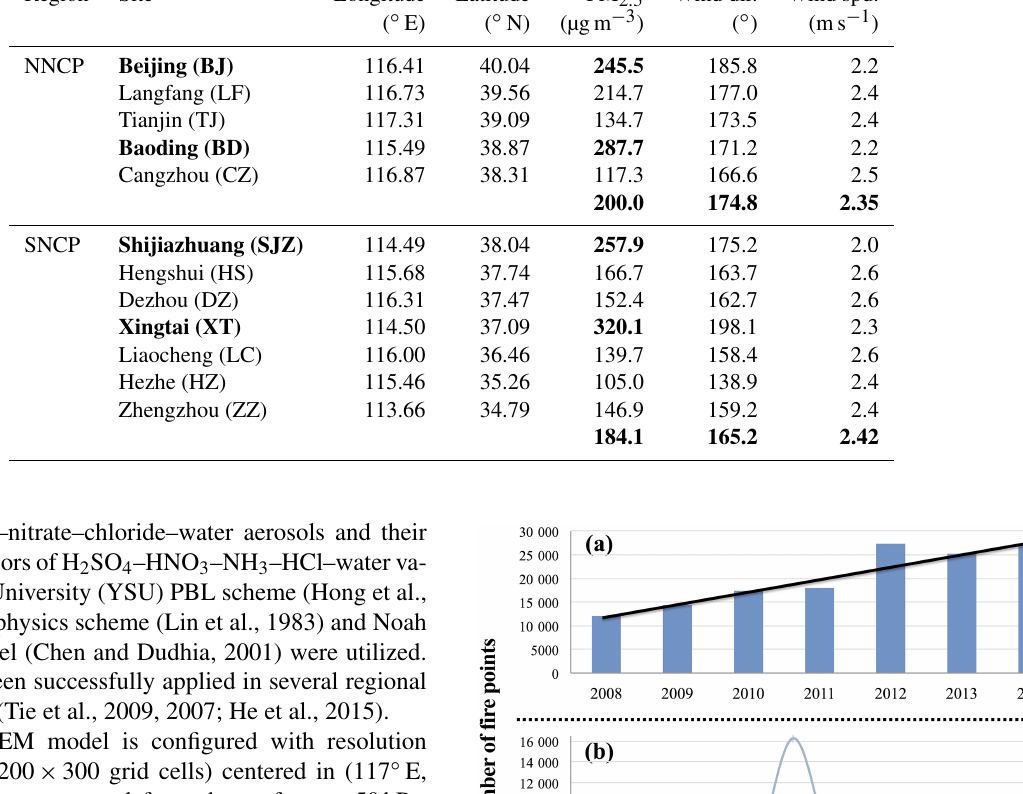
Table 1. The average PM 2 . 5 concentration, wind direction and wind speed of the observations from 12:00 to 00:00LT on 6 to 12 Oct. The sampling sites located at the foot of mountains are emphasized in bold. Region Site Longitude Latitude PM 2 . 5 Wind dir. Wind spd.